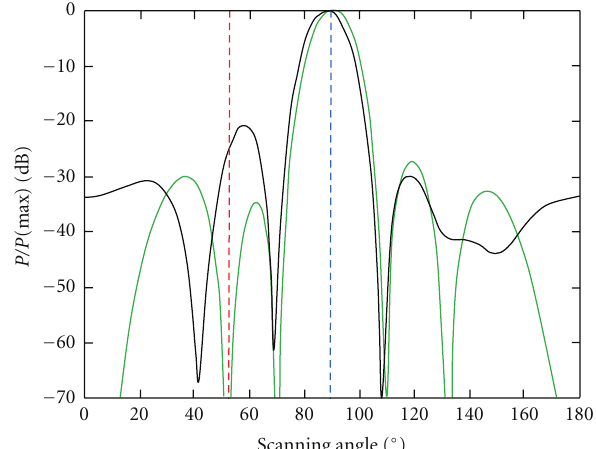
Figure 7: The ANN beam pattern received with 12 neurons in the hidden layer—the beam pattern setting to zero on the interference direction.